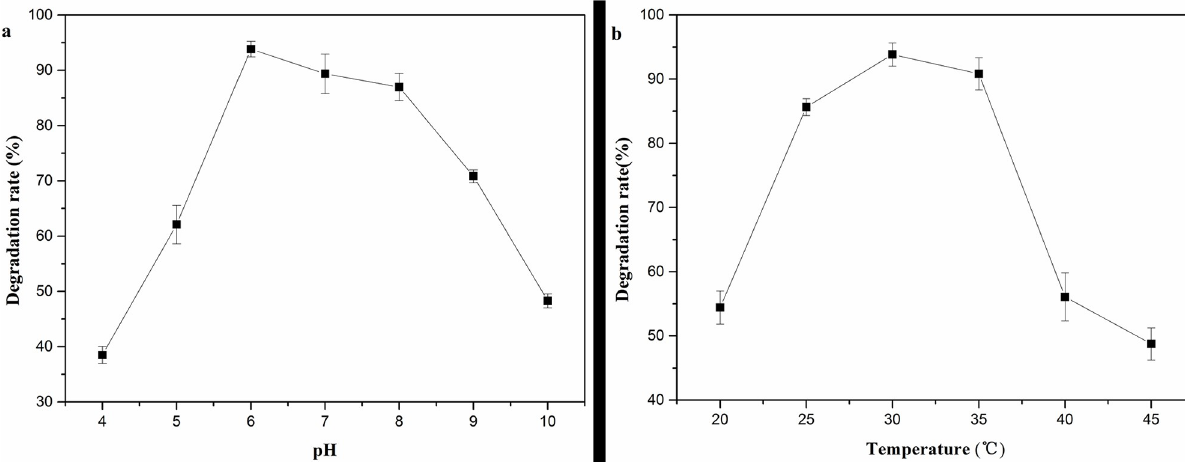
Fig 2. Effects of pH(a) and temperature(b) on DEHP (1000 mg/l) degradation by LF. Average values of three replicates are shown with the standard error of the mean as error bars.